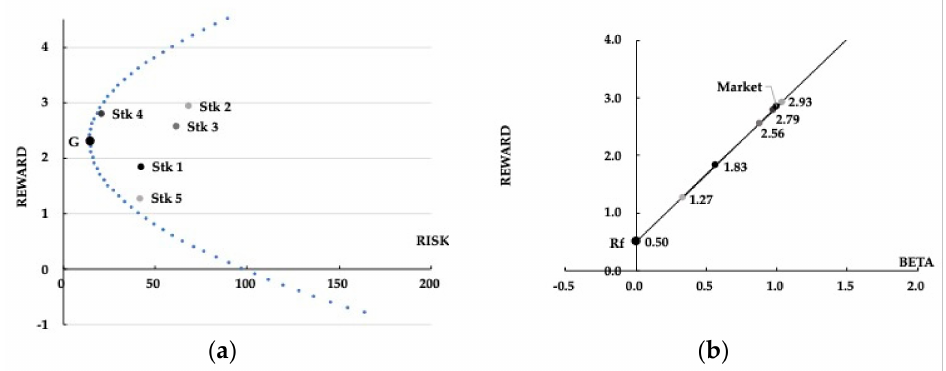
Figure 7. Empirical results in the five-stocks universe; ( a ) portfolio frontier for 5 stocks; ( b ) securities market line for 5